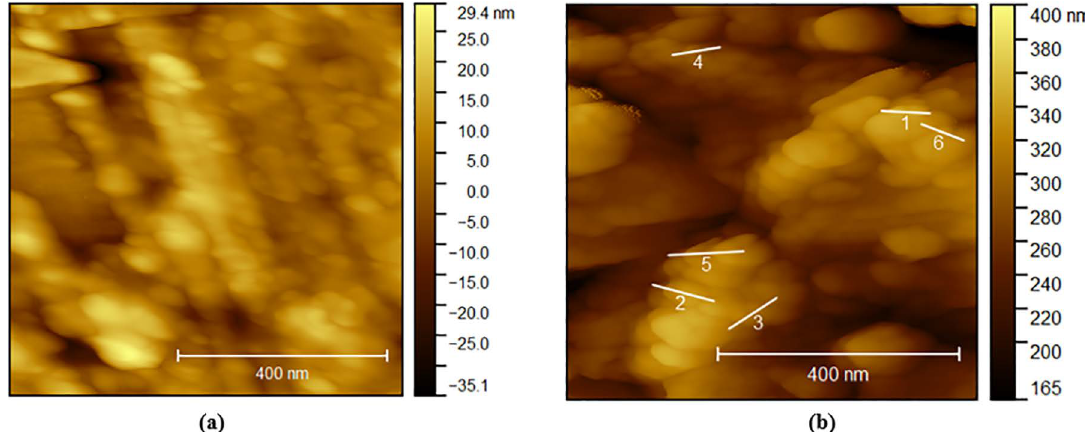
Figure 4. Top view AFM images at a 2.0 x 2.0 µm scanned area, (a) uncoated AA2524-T3 Al-alloy and (b) PAni-NPs/PSS LbL films with 15 bilayers and the